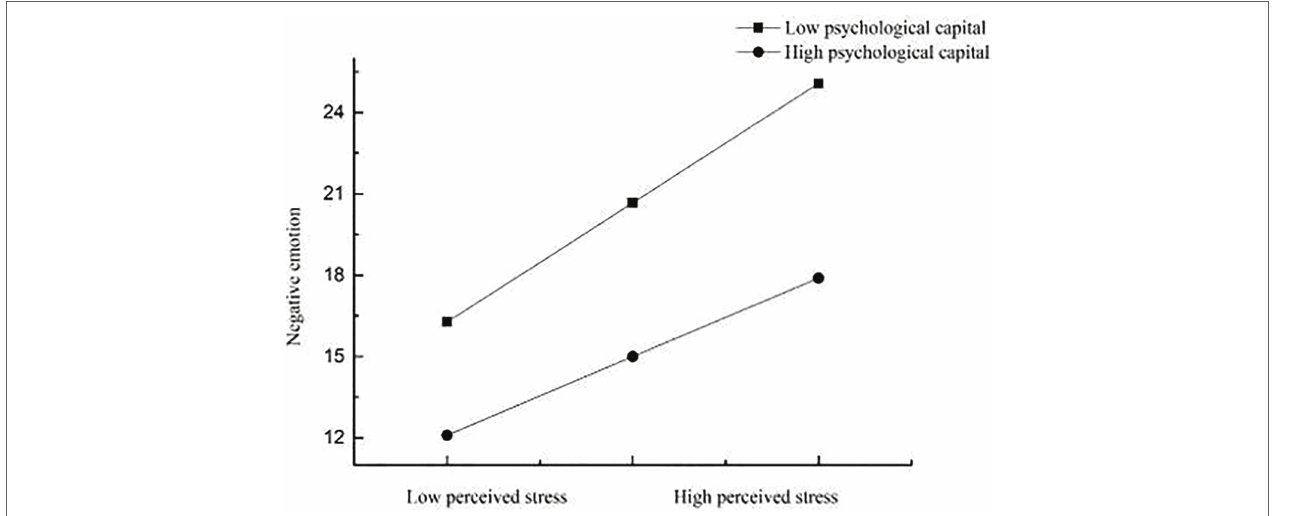
FIGURE 2 | Plot of the relationship between perceived stress and negative emotions at two levels of psychological